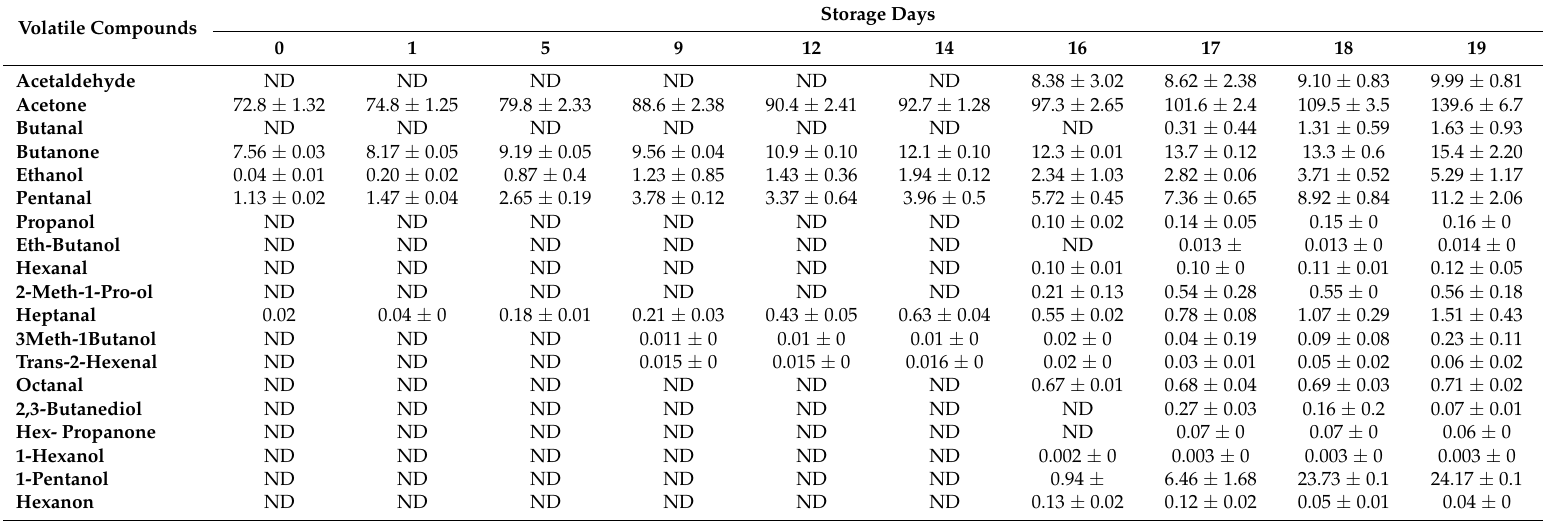
Table 3. Means values and standard deviation of volatile compounds ( µ g/L) of pasteurized milk stored at 10 ◦